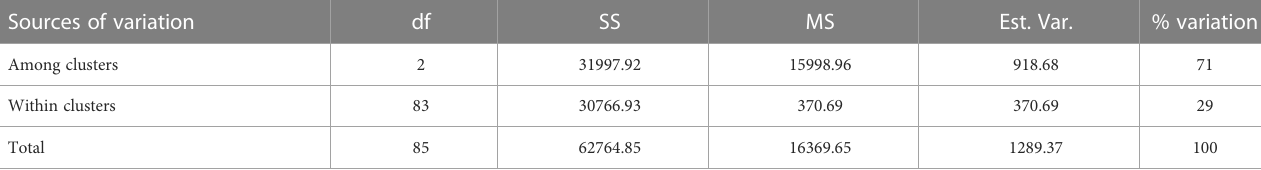
TABLE 4 Analysis of molecular variance (AMOVA) among and within white Guinea yam farmers ’ landraces from Nigeria. Sources of variation df SS MS Est. Var. %